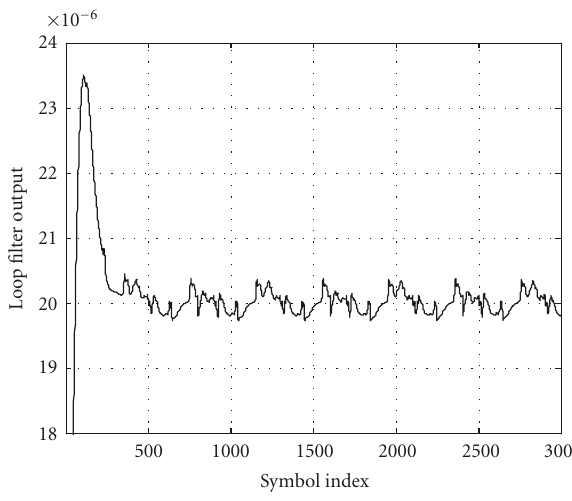
Figure 6: Loop filter output in the channel of Figures 1 and 2 for a frequency error of 20